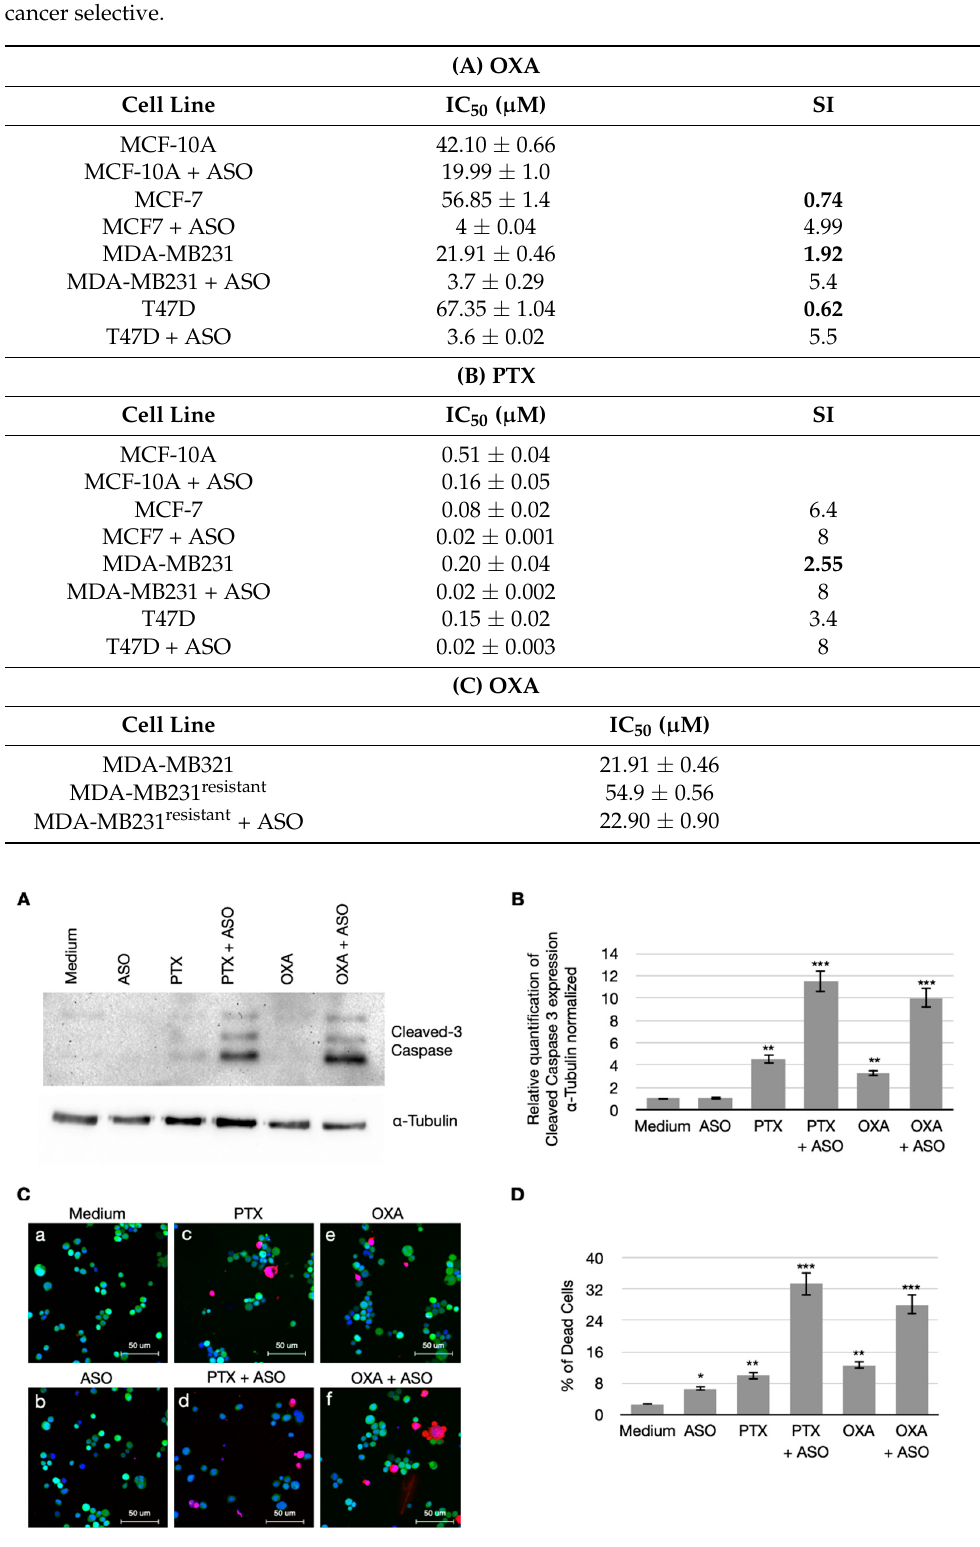
Figure 5. CSA ablation determines a massive apoptosis induction after ASO with PTX or OXA combined treatment in Triple Negative Breast cancer cells (MDA-MB231). Cleaved caspase 3 protein expression levels in MDA-MB231 total cellular extracts after single or combined treatment. Western Blotting was performed using antibodies against cleaved 3-Caspase (Cell Signaling) and α -Tubulin (Sigma Aldrich). The results are the representation of three independent biological repeats ( A ). Graph showing levels of cleaved caspase 3, α -tubulin normalized, in MDA-MB231 cells after treat- ment. Original blots see Supplementary File S1. ( B ). Confocal micrographs of MDA-MB231 cells after treatment, stained for apoptosis assay with Hoechest (HO, blue), Fluorescein diacetate (FDA, green) and Propidium Iodide (PI, red) ( C ). Graph showing the percentage of cell death from apop- tosis assay (n = 500 × 3 independent experiments) ( D ). N.S: not significant, * p < 0.05, ** p < 0.01, *** p < 0.001. 4. Discussion In this paper, we showed that CSA, the complementation group that, together with CSB, is associated to CS, is up-regulated in BC. We demonstrated that CSA ablation per se reduces the tumorigenicity of cancerous cells by dramatically affecting their survival and proliferation. Therefore, as previously demonstrated for CSB, also CSA is upregulated in cancer cells and its ablation seems to perturbate their robustness. The question that arises is why should tumors benefit from CSA over-functionality? Interestingly, CSA is a member of the mixed class of intrinsically disordered proteins (IDPs) as it contains intrinsically disordered internal segments and a long floating tail along with ordered regions. IDPs are characterized by a remarkable conformational flex- ibility and structural plasticity, which allows them to have a huge number of molecular partners and to integrate different biological functions. This is why IDPs play critical roles in regulation and signaling [30]. The integration of various biological processes is a dis- tinctive feature of cancer genes and the important role played by IDPs in this regard is becoming increasingly clear. Interestingly, disordered regions have been strongly associ- ated with dosage-sensitivity oncogenes in cancer [31,32]. It is therefore possible that dos- age sensitivity is related to the ability of proteins to perform molecular interactions via linear sequence motifs as their concentration increases. In this context, we and others have already showed that CSA and CSB proteins play multiple roles in modulating cell robust- ness through the positive regulation of pro-survival adaptive responses including DNA